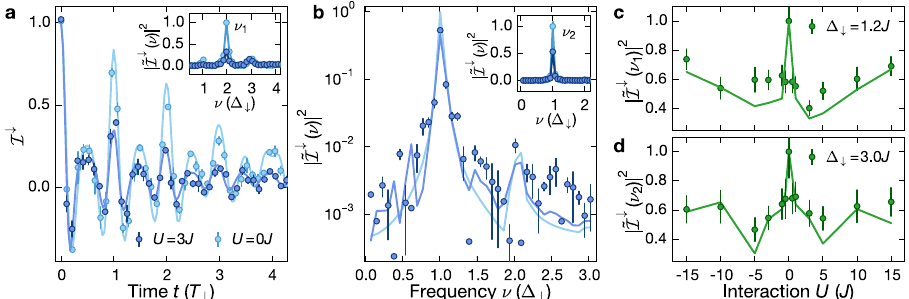
Fig. 2 Short-time interacting Bloch oscillations. a Imbalance I # for U = 0 J (spin-polarized gas, light blue) and U = 3 J (spin-resolved measurement, dark blue) with J / h = 0.88(2)kHz and Δ ↓ = 1.22(1) J . Inset: Power spectral density (PSD) j ~ I ð ν Þj 2 of the time traces shown in the main panel, normalized to the maximum of the non-interacting spectrum; ν 1 = 2 Δ ↓ / h indicates the dominant frequency component. b PSD j ~ I ð ν Þj 2 for U = 3 J (spin-resolved measurement, dark blue), normalized to the maximum of the non-interacting spectrum; J / h = 0.54(1) kHz and Δ ↓ = 2.96(3) J . The data were obtained from time-traces as in ( a ). Inset: PSD as in the main panel and for U = 0 J (spin-polarized gas, light blue). ν 2 = Δ ↓ / h indicates the dominant frequency. c , d Interaction scan of the peak power spectral density j ~ I ð ν j Þj 2 evaluated by summing the PSD in a window of ±3 data points around the dominant frequency ν j , j = {1, 2} at c Δ ↓ = 1.22(1) J and d Δ ↓ = 2.96(3) J obtained from traces as in ( a ). Each data point in ( a , b ) consists of four independent measurements and the error bars denote the standard error of the mean (SEM). Solid lines in all panels are numerical simulations using TEBD ( “ Methods ” ).